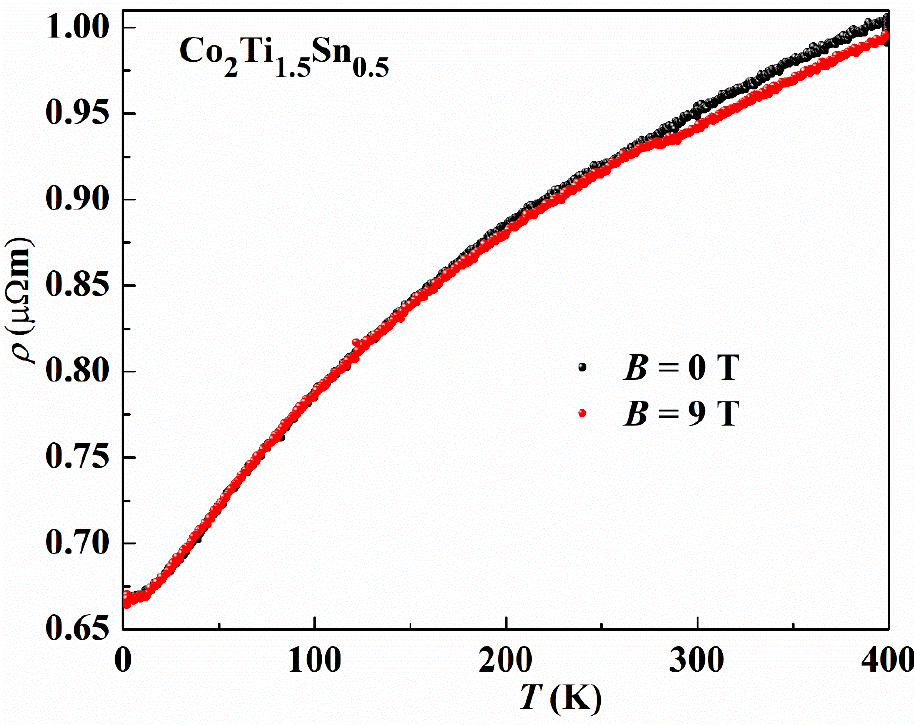
Figure 6. Temperature dependence of resistivity for Co 2 Ti 1.5 Sn 0.5 in B = 0 T and B = 9 T.